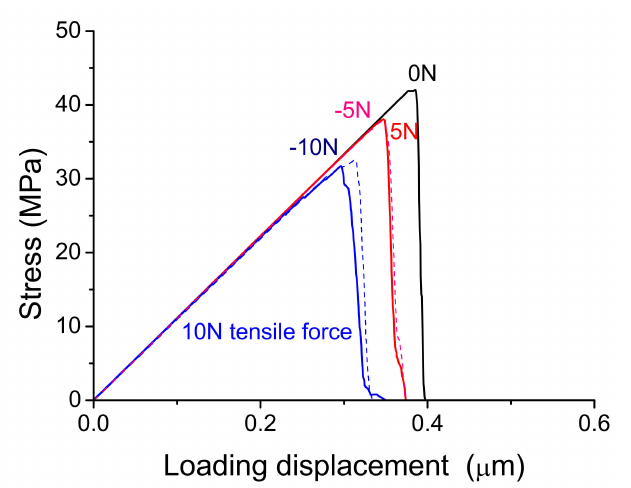
Figure 8. Effect of residual force on interface strength of the interfaces with residual tensile force of 10 N (blue solid curve) and 5 N (red solid curve), the black solid curve represents the result without residual force and the dashed navy and pink curves correspond to the results with residual compressive forces.